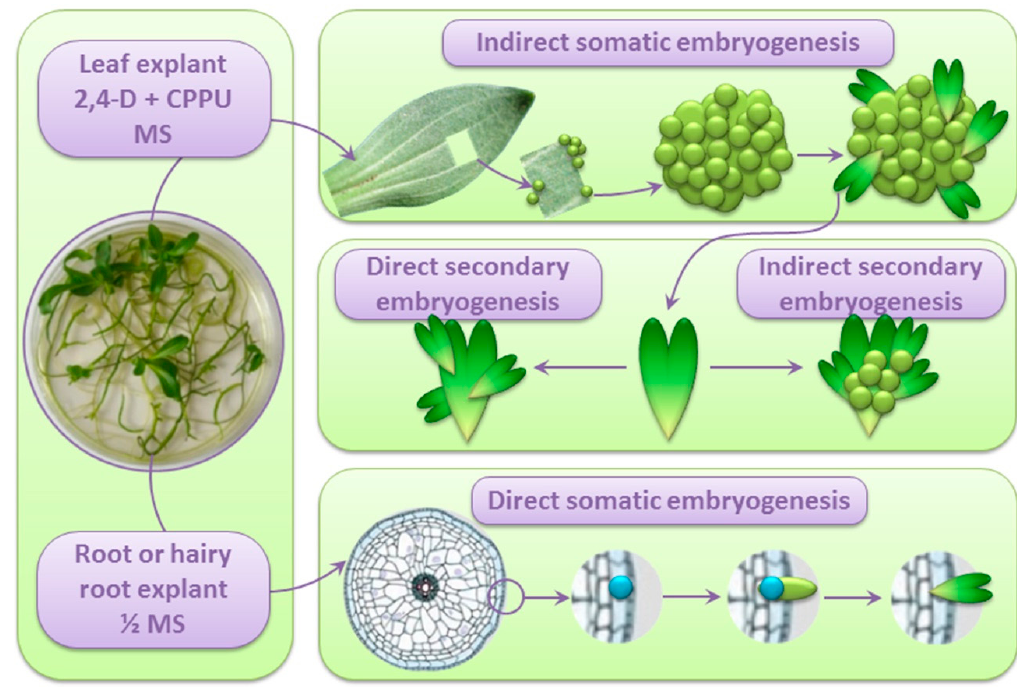
Figure 3. Schematic overview of SE in Centaurium erythraea . Left panel: Both leaves and roots of the in vitro grown C. erythraea plants can serve as sources of explants for the induction of SE. Hairy root cultures can also be used as explants. Upper panel: SE can be induced from leaf explants on the inductive medium containing 2,4-D and CPPU, both in the light and in darkness. Somatic embryos form from differentiated somatic cells in the subepidermal layer of the leaf explant. In this case, SE is indirect and proceeds via the callusing phase. Middle panel: The obtained somatic embryos can be further used as explants for secondary or cyclic embryogenesis [40] Lower panel: SE from root or hairy root explants is spontaneous, on ½ MS medium and direct. SE starts with asymmetric divisions of single totipotent cells from the epidermal or subepidermal layers of root explant. Successive divisions give rise to somatic embryos.